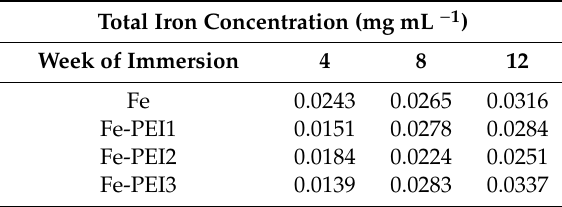
Table 6. Total iron concentration observed in the Hanks’ solution after 4, 8, and 12 weeks of immersion of cellular sca ff olds with polymer (PEI)